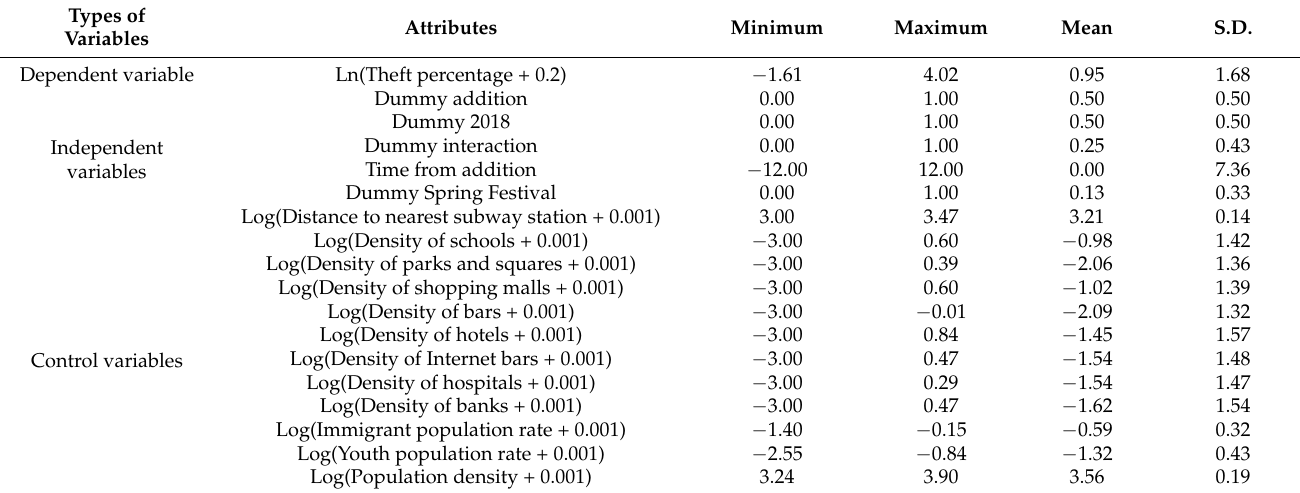
Table 3. Descriptive statistics of variables.